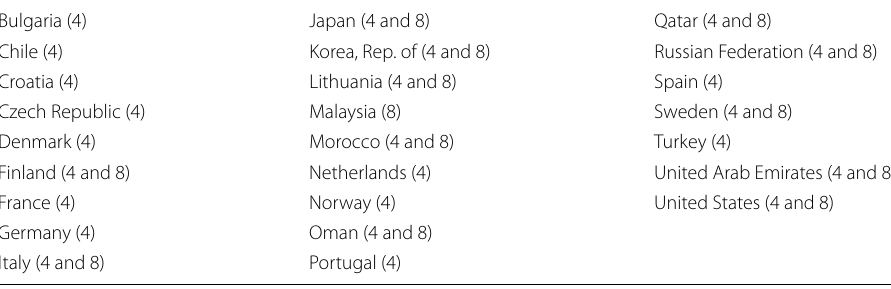
Grade(s) of participation appear in parentheses Chile participated informally with a small sample of students at the fourth